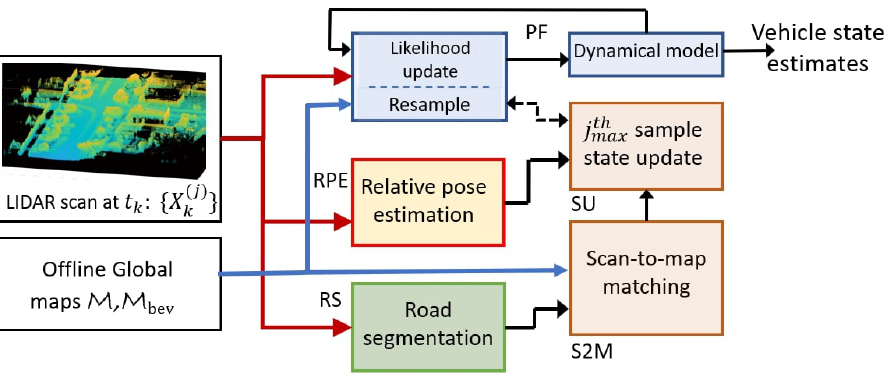
Figure 2. Processing steps in one iteration of the proposed scan matching-based particle filtering approach. The dotted arrow between SU and PF indicates an update only when the computation is